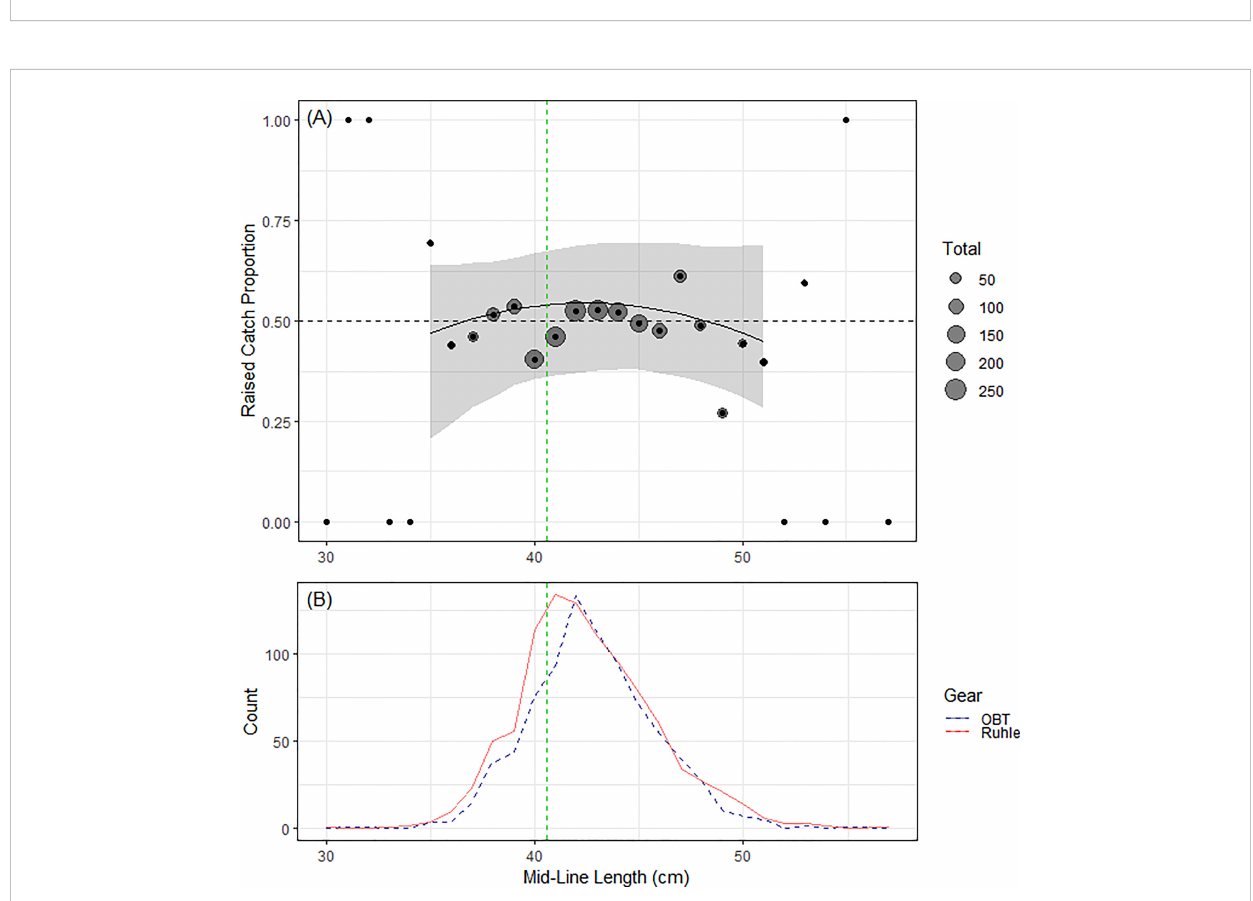
FIGURE 11 Best fi t GLMM model (black line), con fi dence region (gray area) and catch proportions-at-length (OBT catch/Total catch; open circles) raised by the inverse of the proportion of the subsamples (A) and length frequency distributions (B) for haddock mid-line lengths (x-axes) in the OBT and Ruhle trawls during trip 2. Points outside the gray region in the panel A were not used in the GLMM. Diameters of raised catch proportions are scaled by observation numbers. Dotted green lines are the MLS of